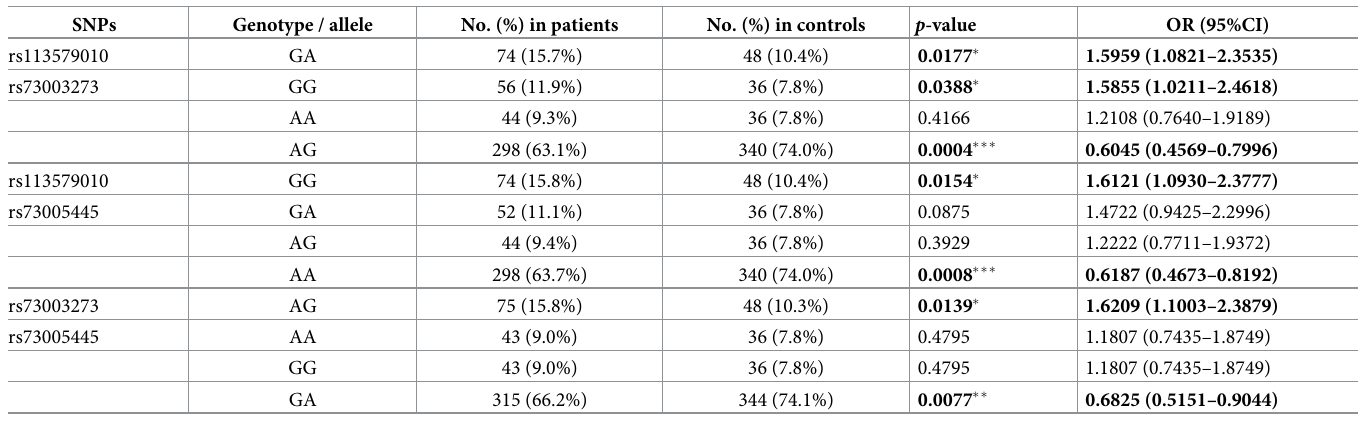
Table 3. Haplotype frequencies of selected SNPs in UCA1 gene between endometriosis patient and controls 1 .